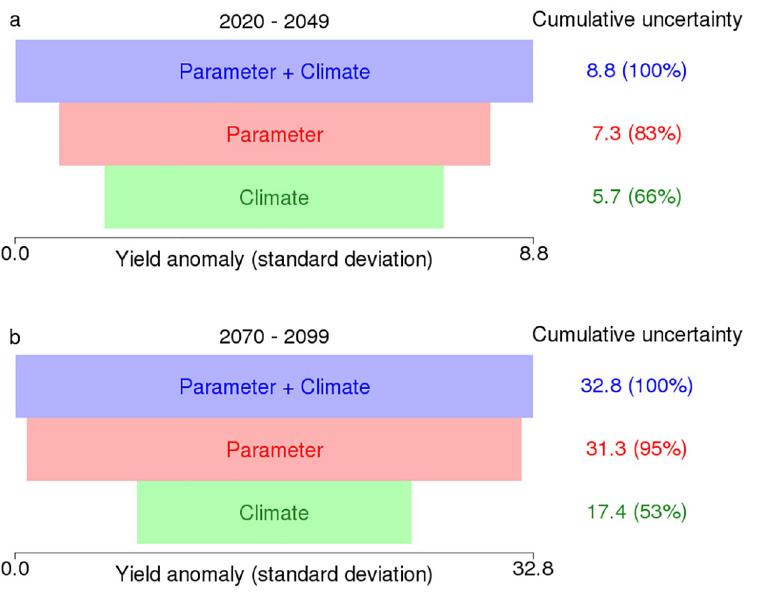
Fig 4. Decomposition of the uncertainty in 30-year mean yield distributions. The uncertainties are measured in yield anomaly standard deviations. Two panels are for two periods. a : 2020–2049 b : 2070–2099. The percentages are the proportion of the uncertainty cumulatived up to each